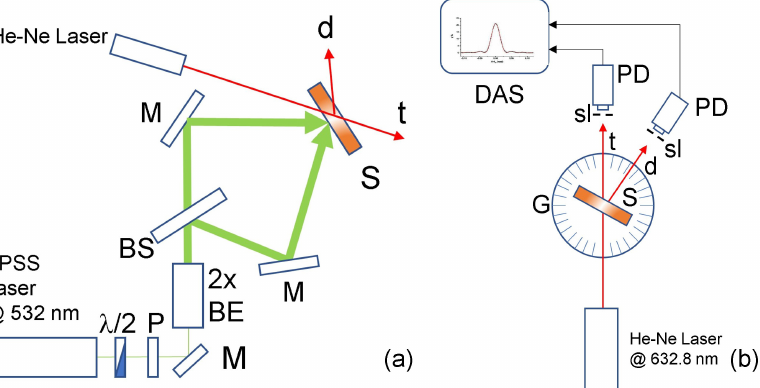
Figure 1. Schematic representation of the writing ( a , b ) angular analysis set-ups. G = computer- controlled goniometer; λ /2 = half wavelength plate; P = polarizer; M = mirror; 2x BE = 2x beam expander; BS = beam splitter; S = sample; d and t = diffracted and transmitted beams, respectively; PD = photo-detector; sl = slit; DAS = data acquisition system.